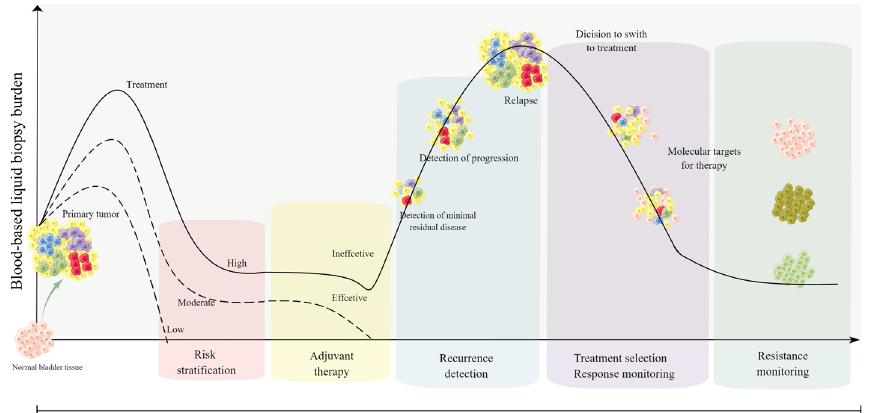
Fig. 2 Overview of the clinical use of liquid biopsy in bladder cancer. Sample analysis of bladder cancer biomarkers early in the disease process allows for early diagnosis and risk stratification. After receiving surgery, liquid biopsy can detect minimal residual disease as a prognostic indicator and allow early detection of recurrent disease. During treatment, liquid biopsy can enhance longitudinal surveillance through its noninvasive approach, thus enabling continuous sampling. In addition, liquid biopsies have the advantage of capturing the entire tumor genome, which can help identify novel genetic markers for targeted therapy and detect treatment